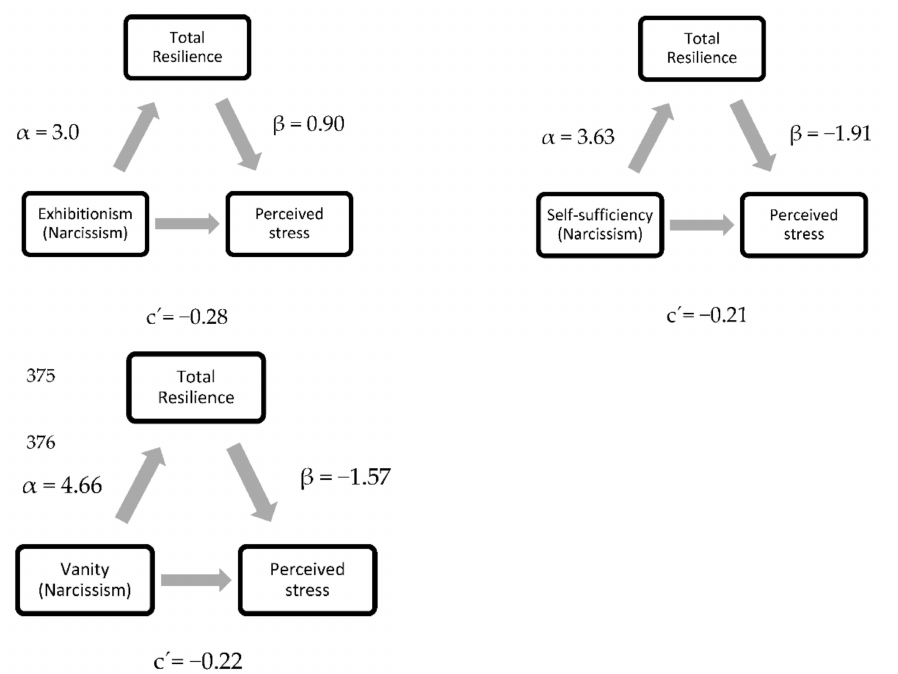
Figure 2. Statistical diagrams of partial mediation effects of Resilience on the relation between Narcissism and Perceived